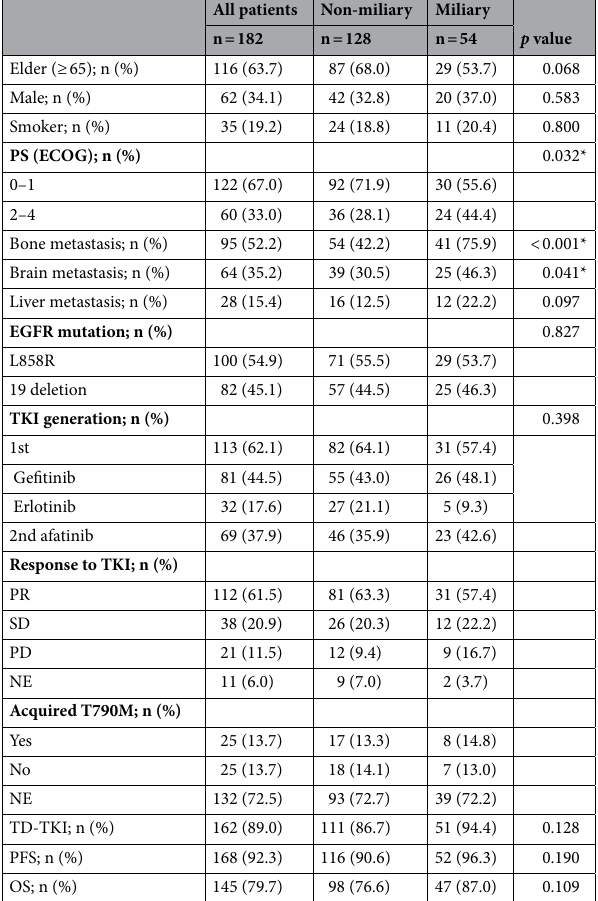
Table 1. Clinical characteristics of the NSCLC patients with contra-lateral lung metastasis harboring EGFR mutation. PS: performance status, ECOG: Eastern Cooperative Oncology Group, PR: partial response, SD: stable disease, PD: progression disease, NE: not evaluable, * p value <